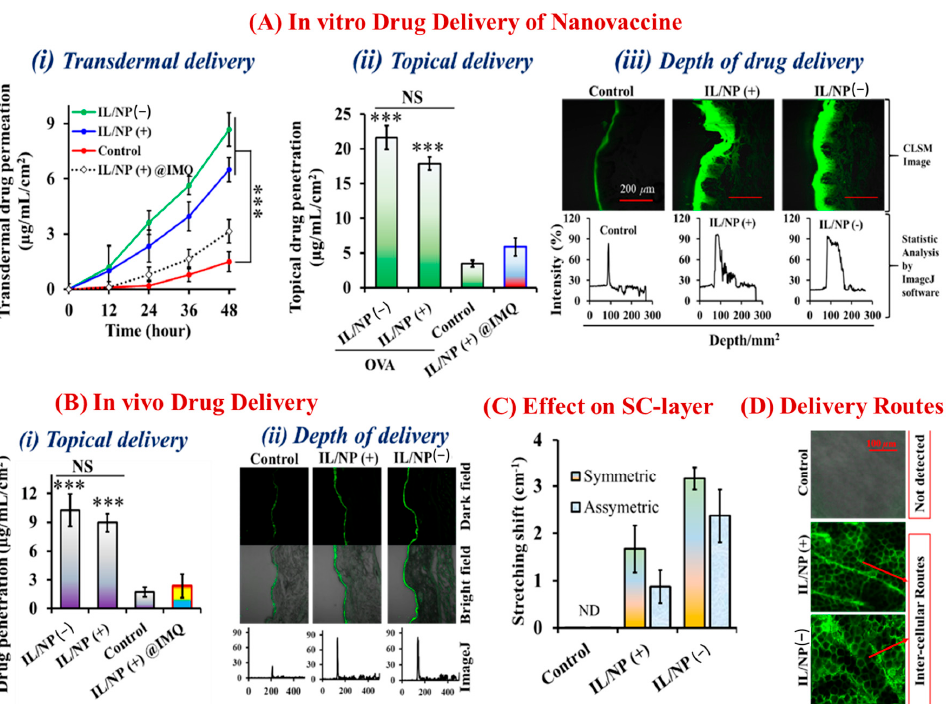
Figure 3. ( A ) In vitro (i) transdermal delivery, (ii) topical delivery, and (iii) depth of drug delivery into YMP skin via the nanovaccine. ( B ) In vivo topical delivery of FITC-OVA and IMQ via the nanovaccine in C57BL/6N mice. ( C ) Effect of the nanovaccine on the SC. ( D ) Intercellular route of FITC-OVA delivery. IL/NP(+) is the formulation containing IMQ, whereas IL/NP( − ) is the formulation lacking IMQ. Data are presented as the mean ± SD (n = 3). *** p < 0.001, and IL/NP(+) @IMQ is a nanovaccine formulation without cosurfactant (S-20). NS = not signi fi cant, and ND = not detected.